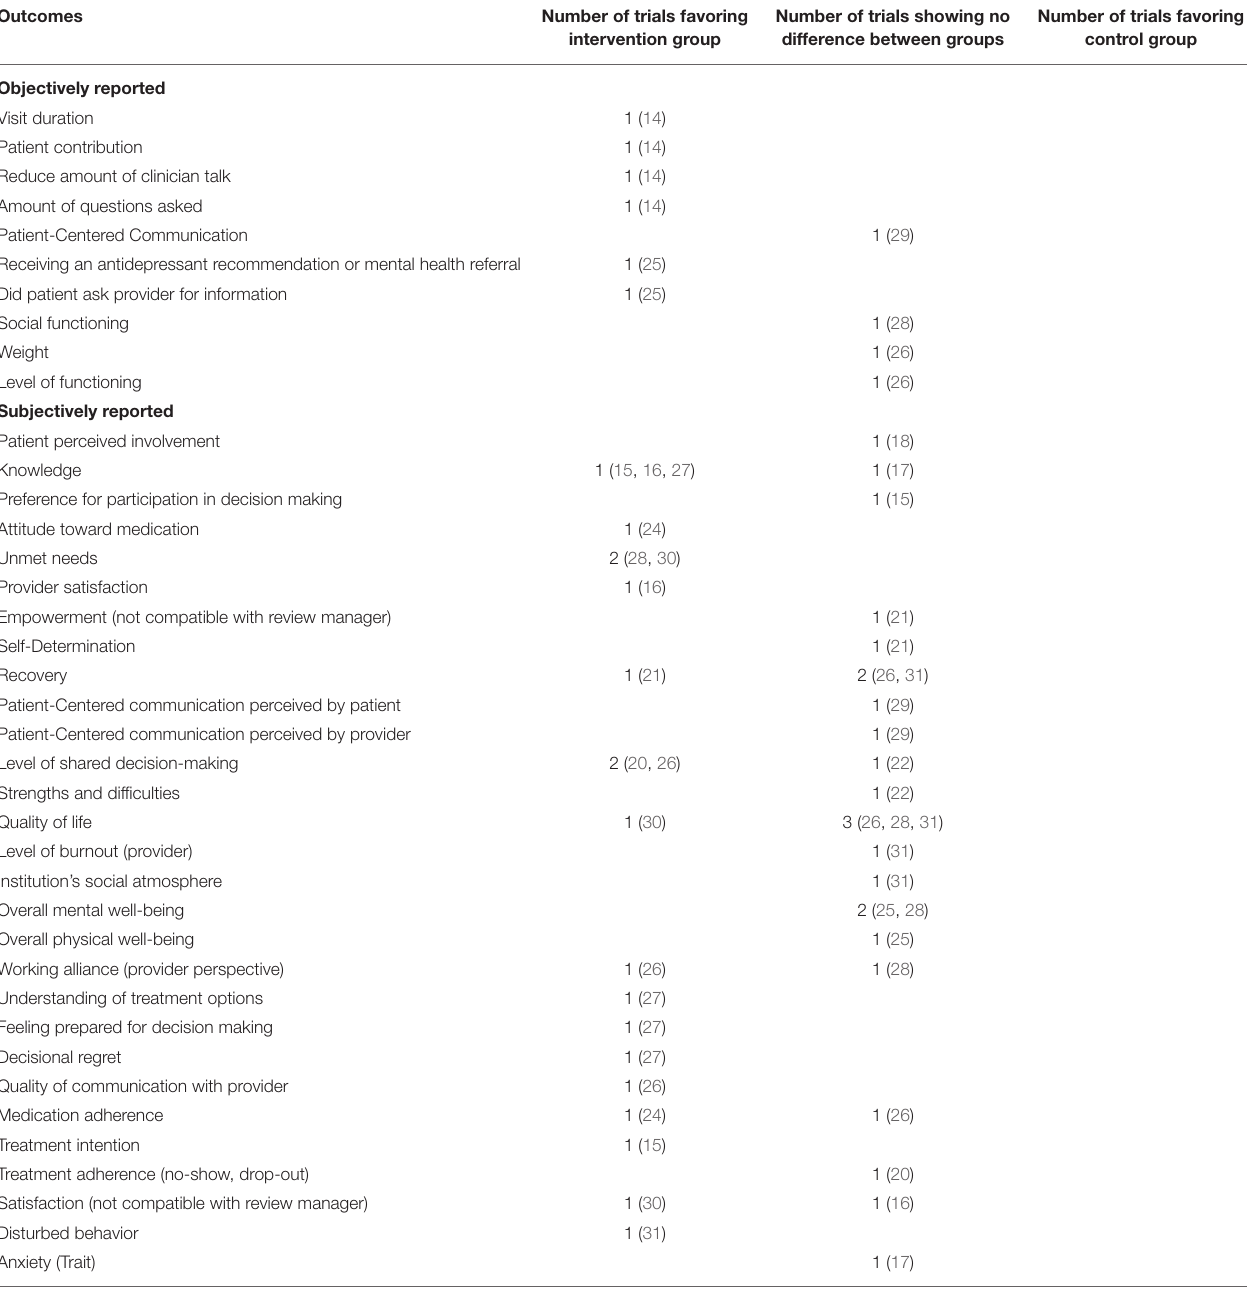
TABLE 2 | Results of the narrative synthesis of 39 outcomes. Outcomes Number of trials favoring